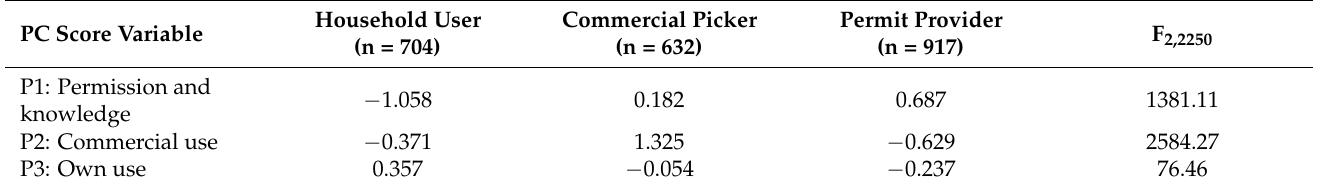
Table 6. Forest owner grouping based on the PC score variables on the utilisation of the NTFPs of their forests (n = 2253). F-values reveal the contribution of the PC score variables in the clustering.